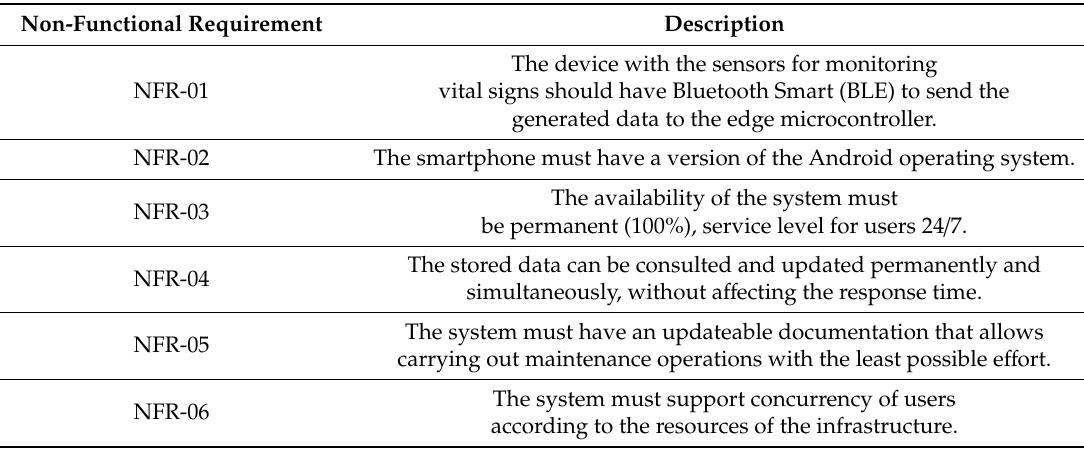
Table 3. IoMT app non-functional